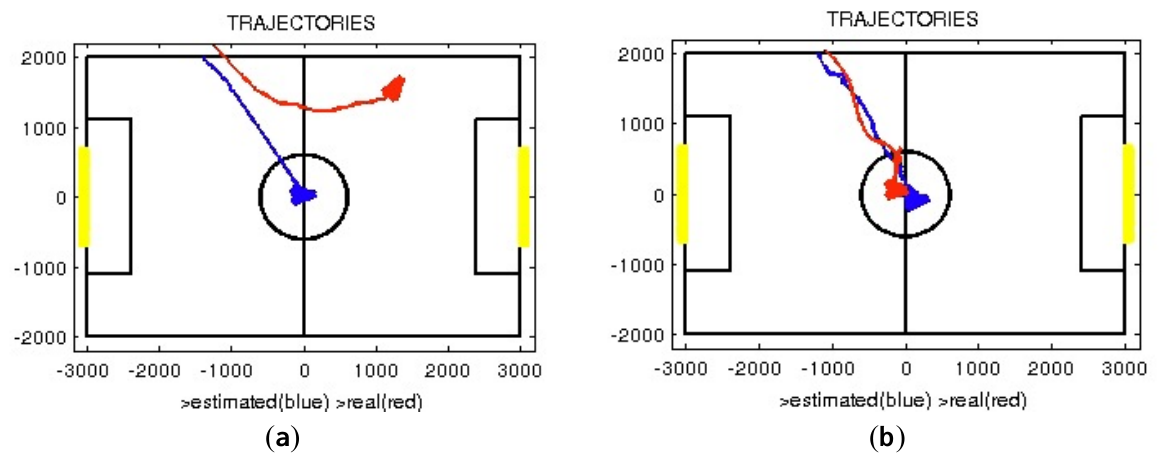
Figure 22. Positioning accuracy tests results using: ( a ) Path followed using odometry-based system; ( b ) Path followed using the localization system.